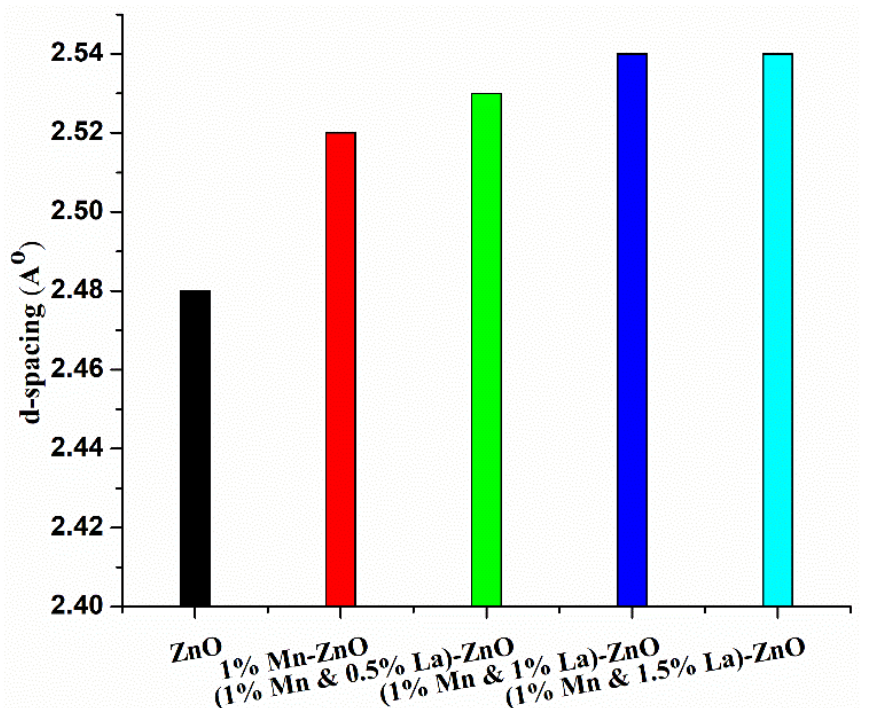
Figure 3. Graph of d-spacing based on the composition of thin films.